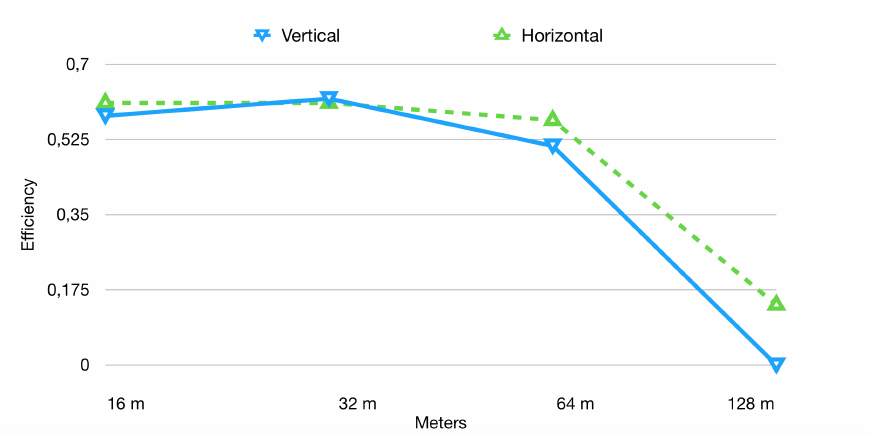
Figure 5. RFID data reception rate in long-range